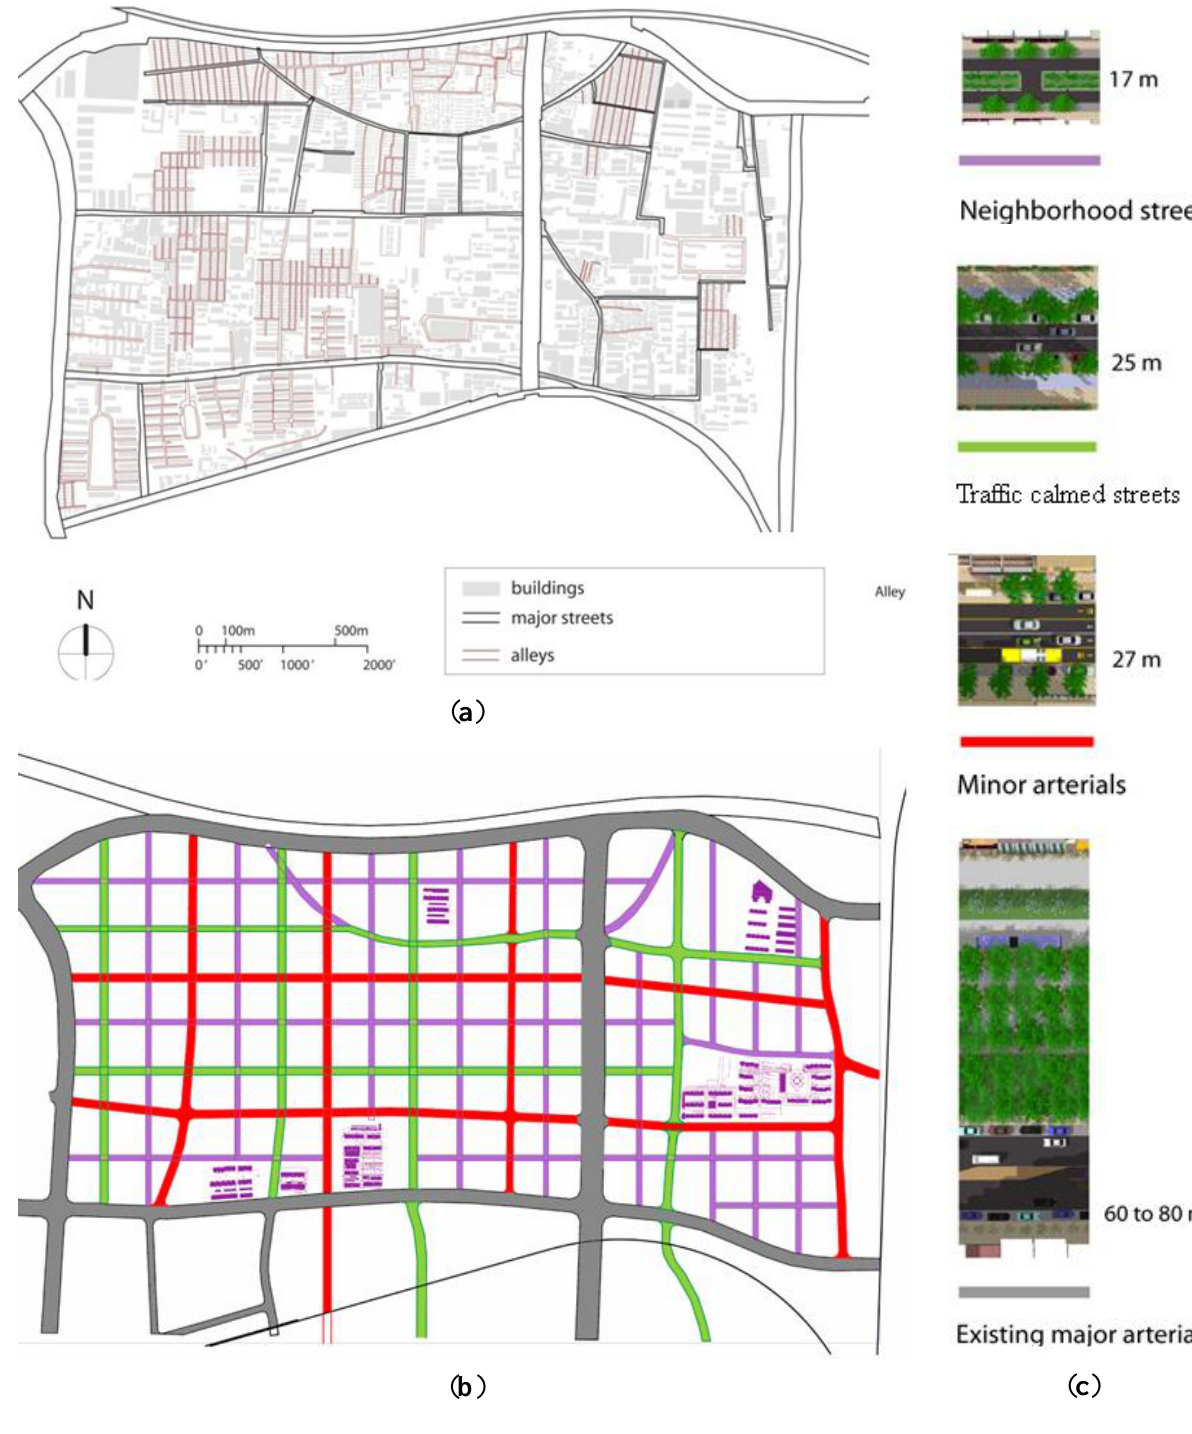
Figure 1. Luokou street network. ( a ) existing street network; ( b ) proposed street network; ( c ) types of